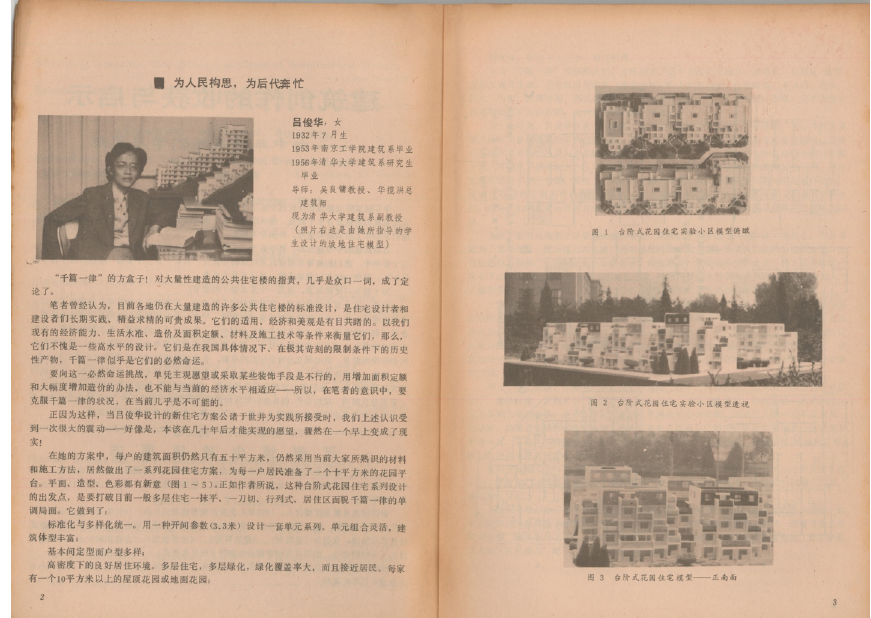
Fig. 8 The presentation of Lv Junhua’s work in